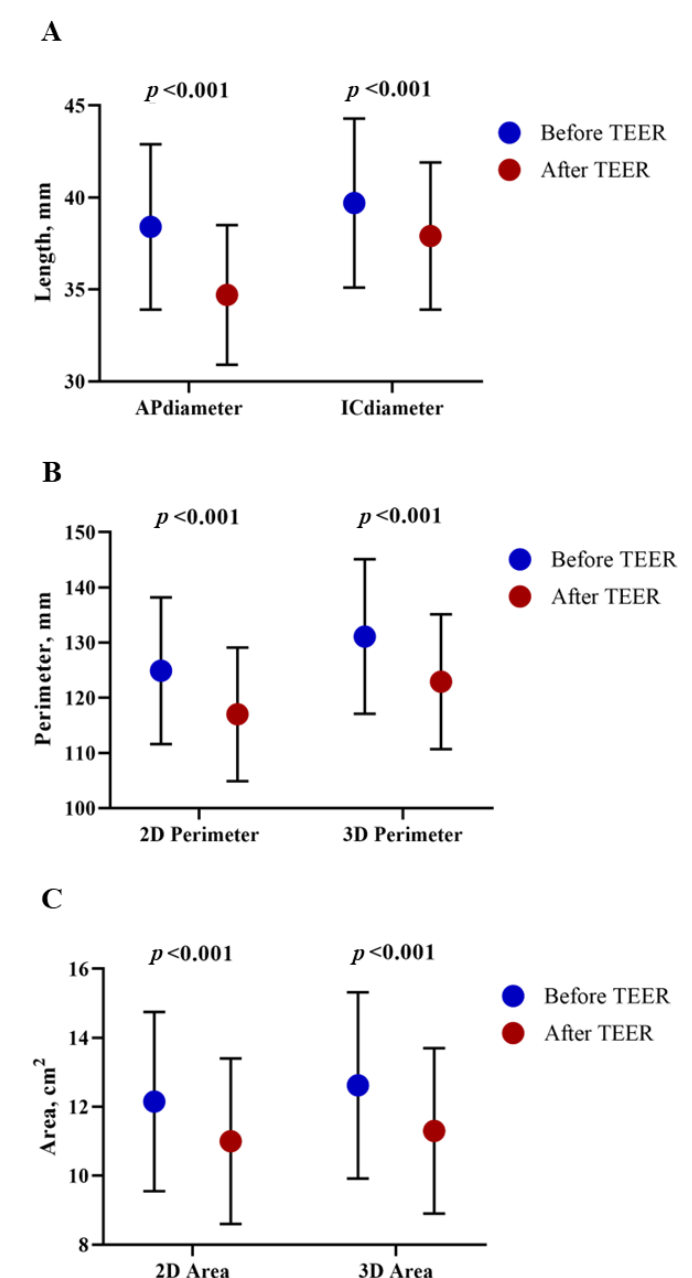
Figure 1. Mean values of mitral valve diameters ( A ), perimeters ( B ), and areas ( C ) before (blue dots) and after (red dots) TEER. Error bars represent standard deviation.